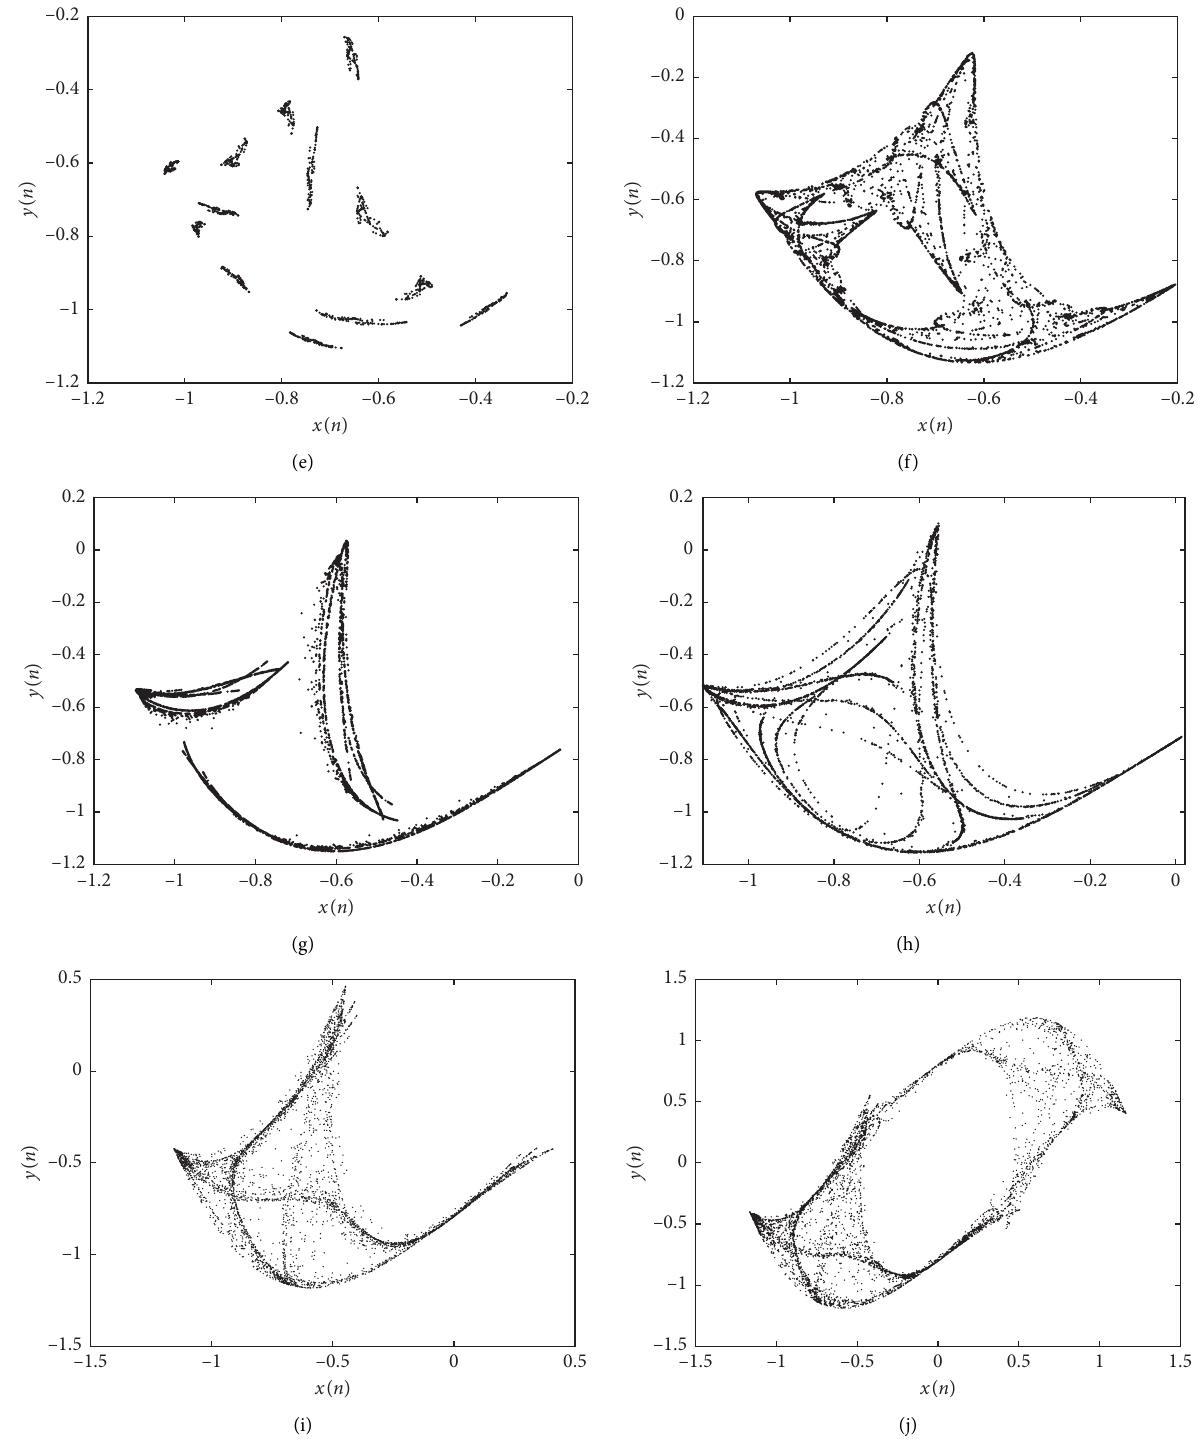
Figure 9: The phase diagrams of system (10) with the initial condition x (f) υ � 0 . 86, (g) υ � 0 . 89, (h) υ � 0 . 90, (i) υ � 0 . 95, and (j) υ � 0 .